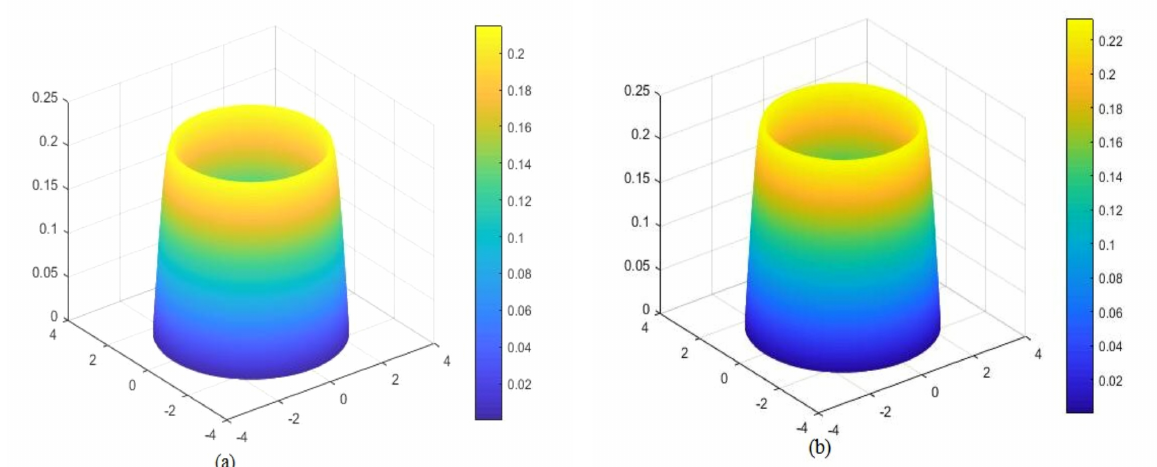
Figure 2. ( a ) The NBE solution u k at t = 0.2. ( b ) The analytical solution u k